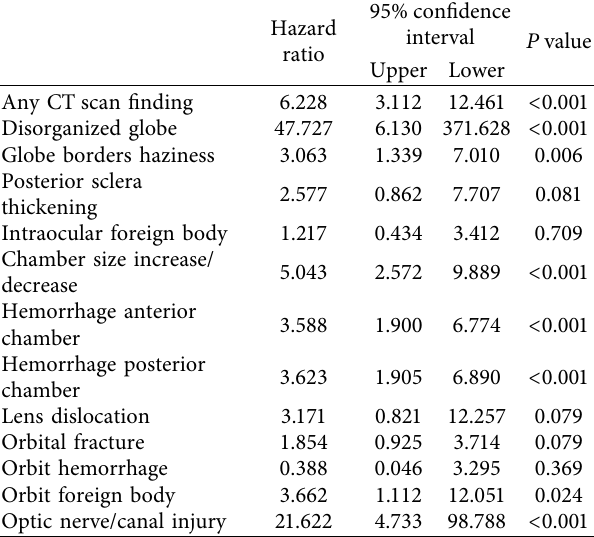
Table 3: Prognostic value of presence of CT scan findings (sepa- rately) for poor final visual acuity in patients with traumatic eye injury using binary hazard ratio